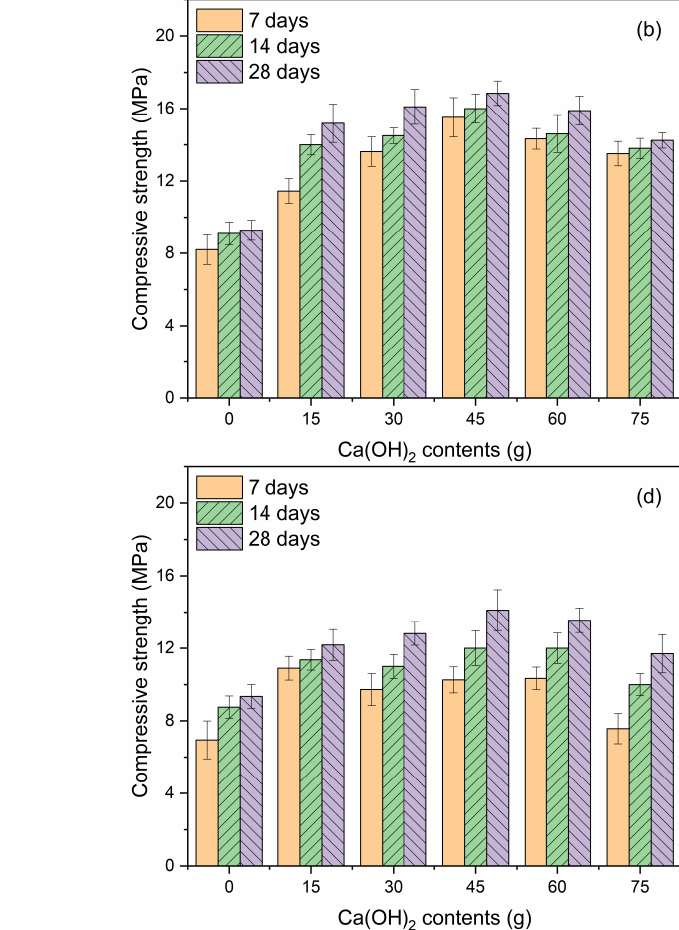
Figure 3. Compressive strength of geopolymeric materials vs. the amount of calcium hydroxide at different concentrations of NaOH: 4 M ( a ), 6 M ( b ), 8 M ( c ), 10 M ( d ).